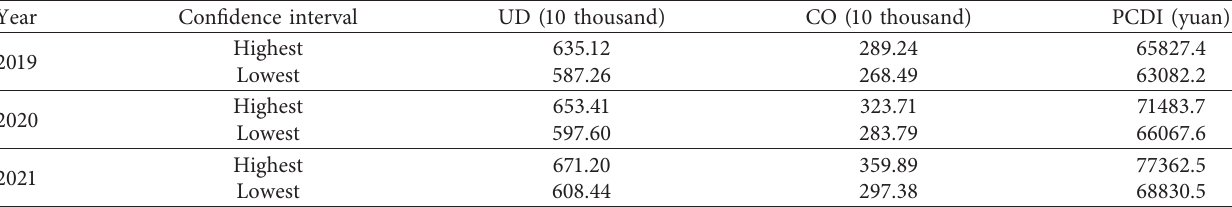
Table 15: Results for the confidence intervals of three types of data in Ningbo (optimistic).